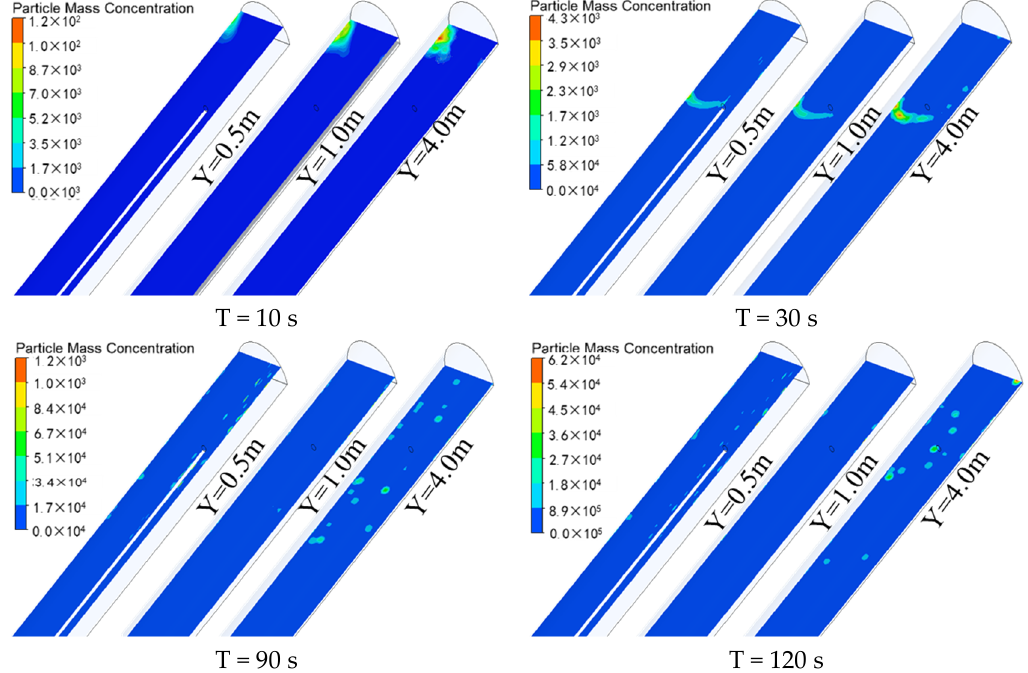
Figure 5. Dust concentration cloud map with time at three height levels.